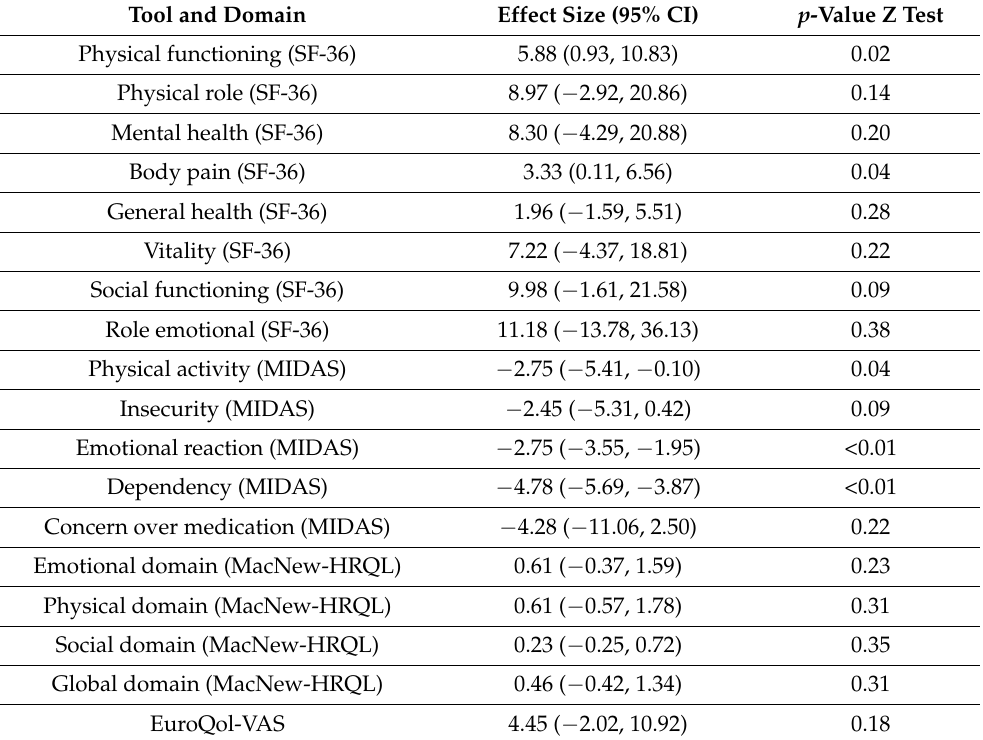
Table 2. Effect size (post-intervention mean